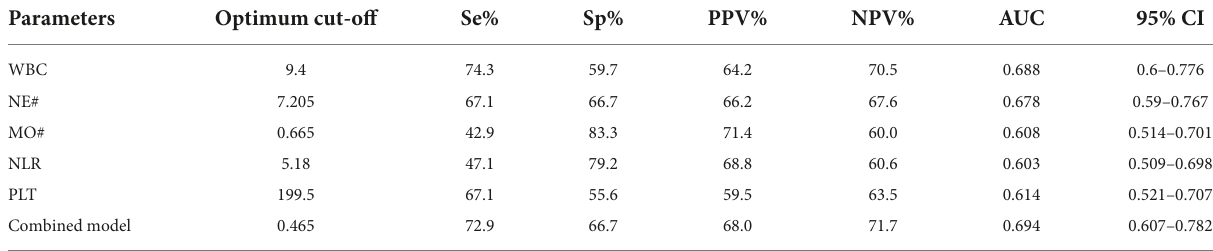
TABLE 5 Performance of tested analytes as the best single under receiver–operator curve (ROC) analysis. Parameters